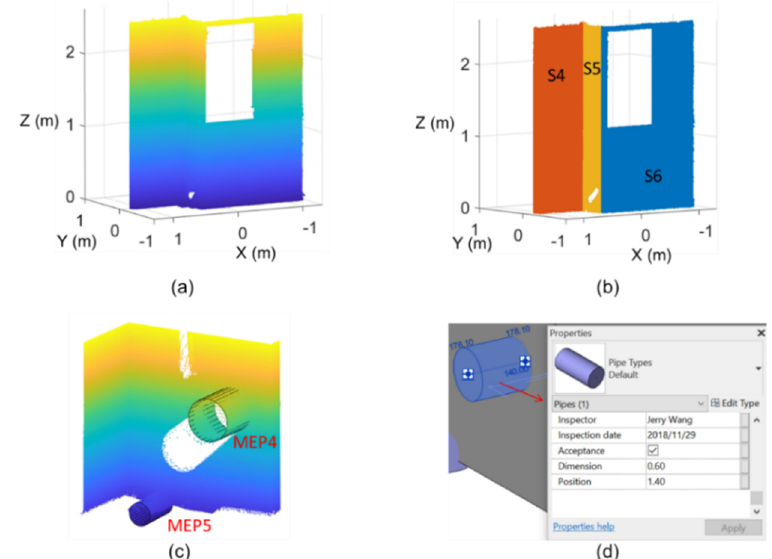
Figure 22. Experimental process for validation experiments: ( a ) scanned data for PBU B after data pre-processing, ( b ) extraction of three planar surfaces S4 to S6 for structural element inspection, ( c ) recognition of MEP4 and MEP5 (as shown in Figure 20) for MEP element inspection, and ( d ) storage of inspection information of MEP4 in BIM model.